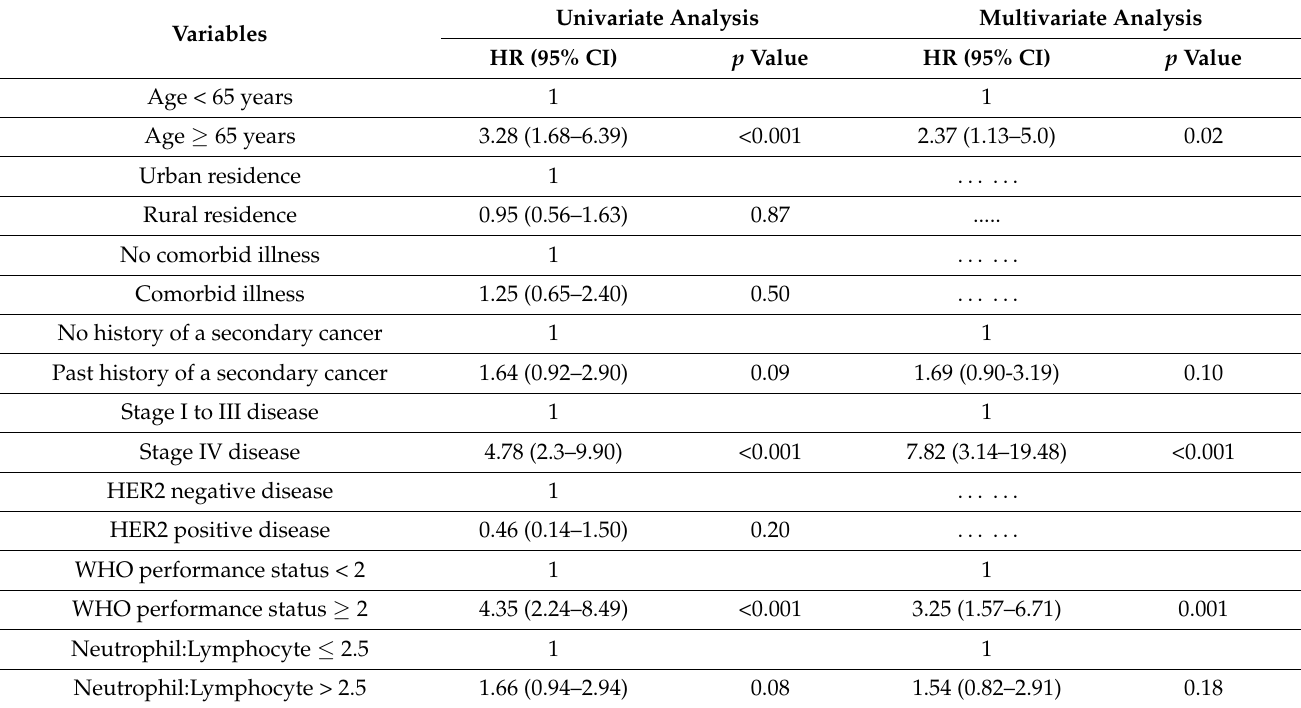
Table 4. Cox proportional analysis for overall survival for 108 patients with all stages of breast